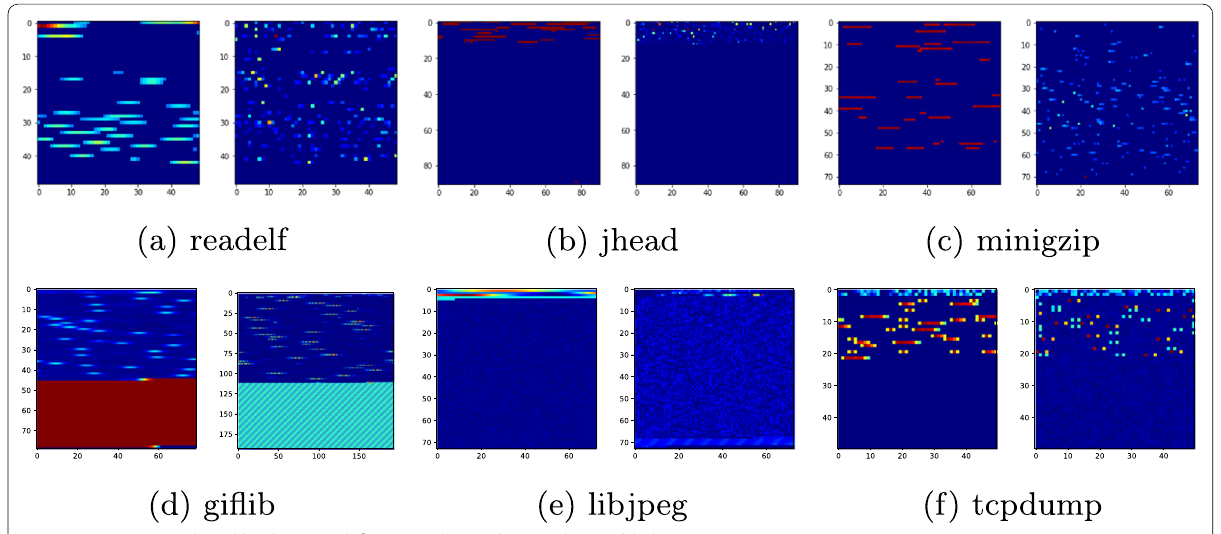
Fig. 4 Heatmap produced by the CAM (left) versus the gradient (right). Highlight parts represent